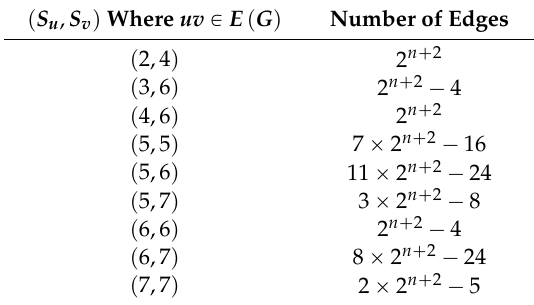
Figure 2. Tetrathiafulvalene dendrimer with 2-growth stages, TD 2 r 2 s [2] . Table 2. Edge partition of tetrathiafulvalene dendrimer TD 2 r n s based on degree sum of neighbors of end vertices of each